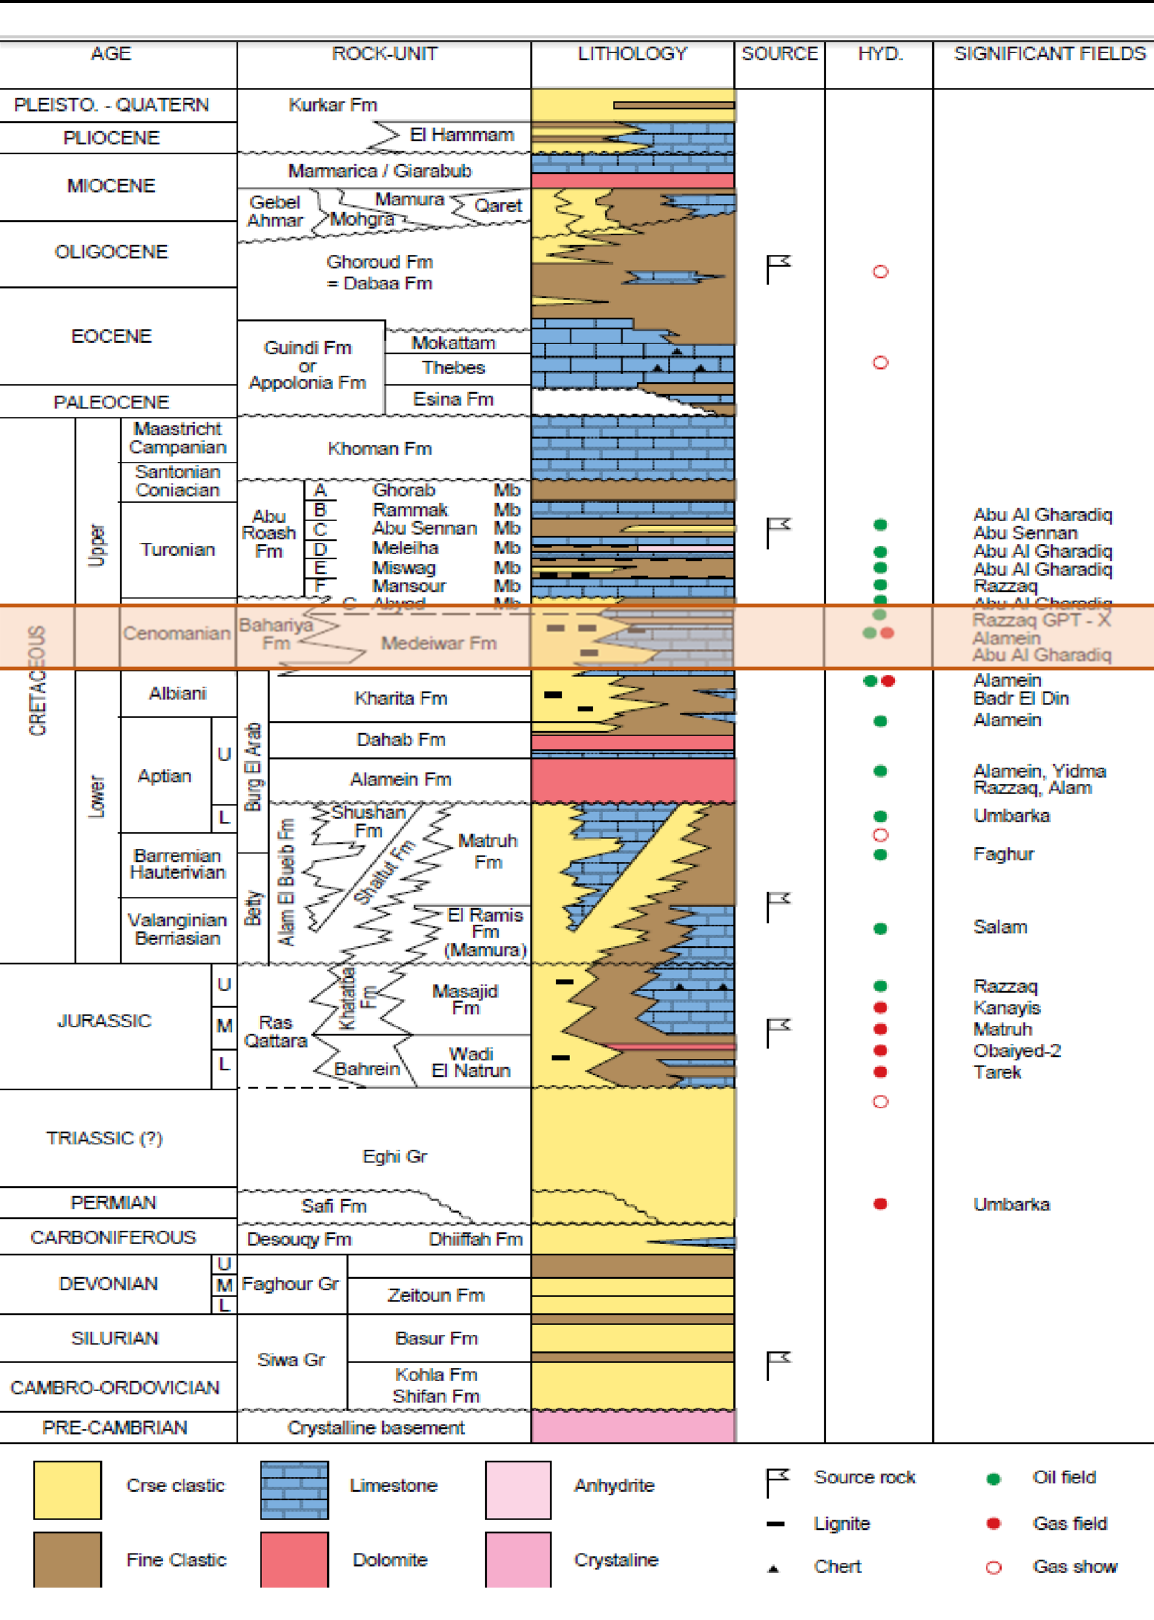
Fig. 3 North Western Desert Stratigraphic column (WEC 1995 by